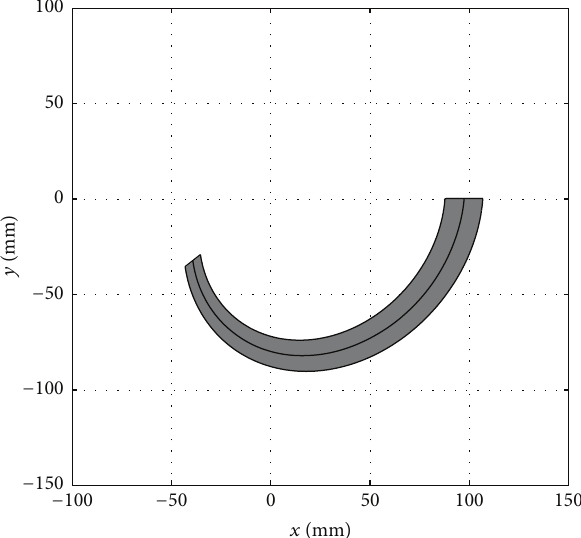
Figure 9: Work area of reconfigurable flexoextensor mechanism (the middle finger case).